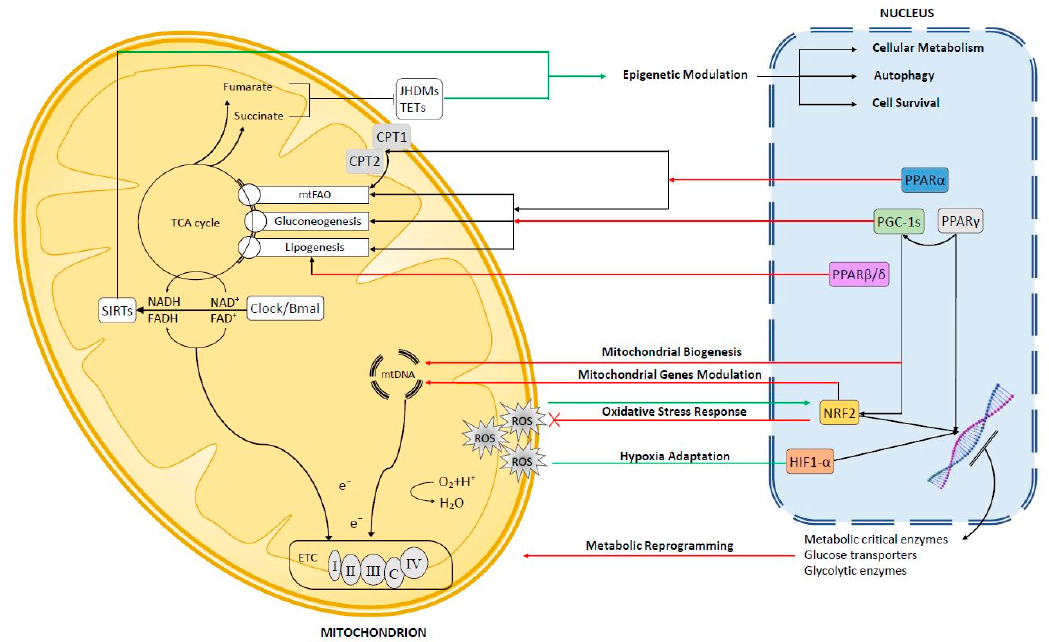
Figure 1. General overview of the mito-nuclear communication in liver cells. Anterograde signaling pathways highlighted in red, retrograde pathways in green.